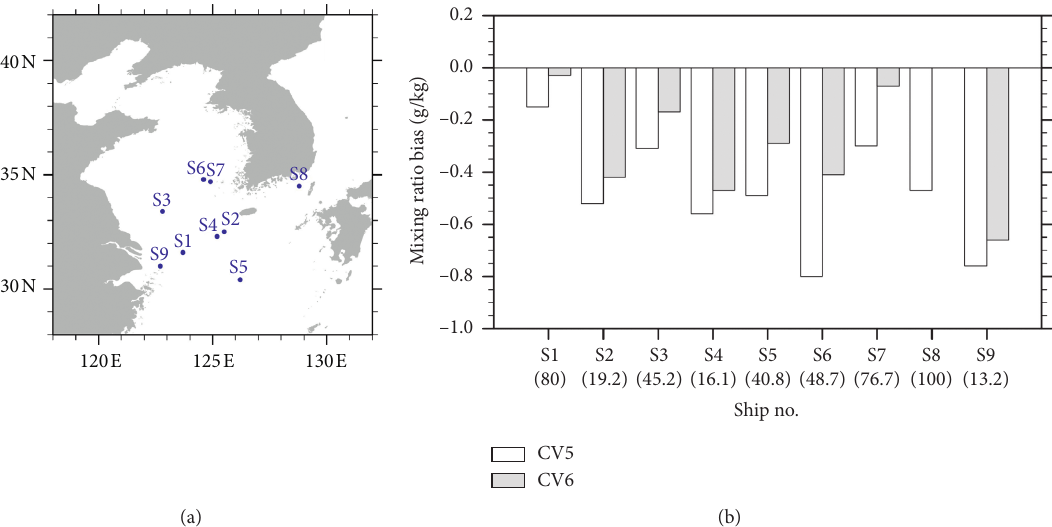
Figure 9: Locations of ship measurements (a) and biases of forecasted mixing ratio compared with observation (b) for Case-A. The improvements (%) of Exp-A_CV6 compared to Exp-A_CV5 are presented below the S# (identified mark of ship sites) along horizontal